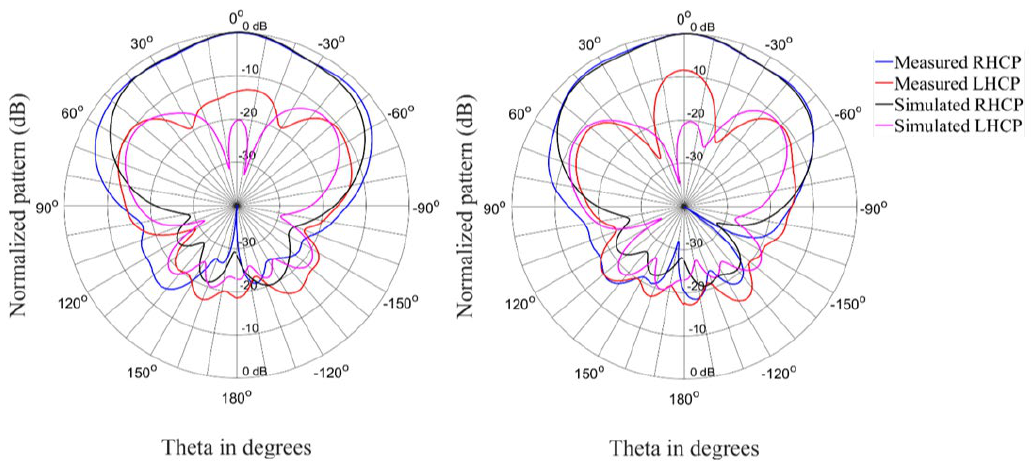
Figure 13. Radiation patterns (Phi = 0° and Phi = 90°) of the antenna in the circular state at 2.4 GHz.